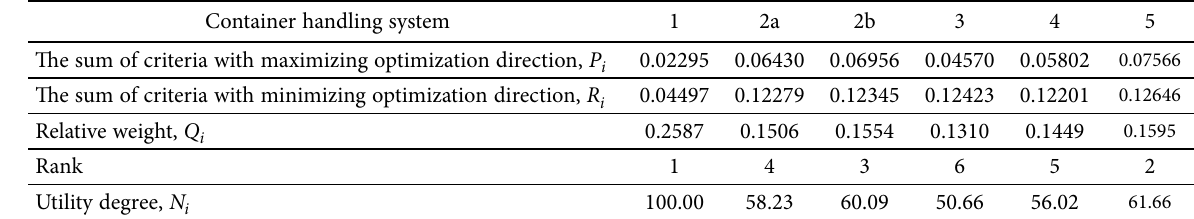
Table 2. The results of multi-criteria